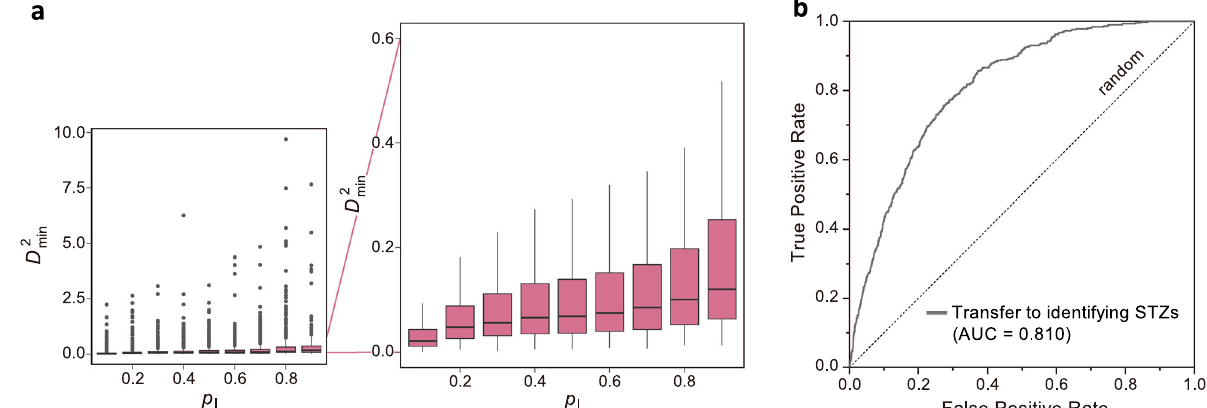
Fig. 6 Transferring ML model to identifying STZs. a Correlation between the probability estimates, p l , from the L- E act model and the non- ) at strain 4.0% of a Cu 64 Zr 36 – 10 9 K s − 1 glass. In the box plots, ends of box spans from 25 to 75% percentile, black af fi ne displacement ( D 2 min line in box represents median, whiskers show 1.5 times the inter-quartile range, and points outside the whiskers show outliers. Outliers are marked in the left plot and are removed in the right plot for clarity. b Receiver operating characteristic (ROC) curve and area under curve (AUC) when using the p l to identify STZs with the largest 5% D 2 min